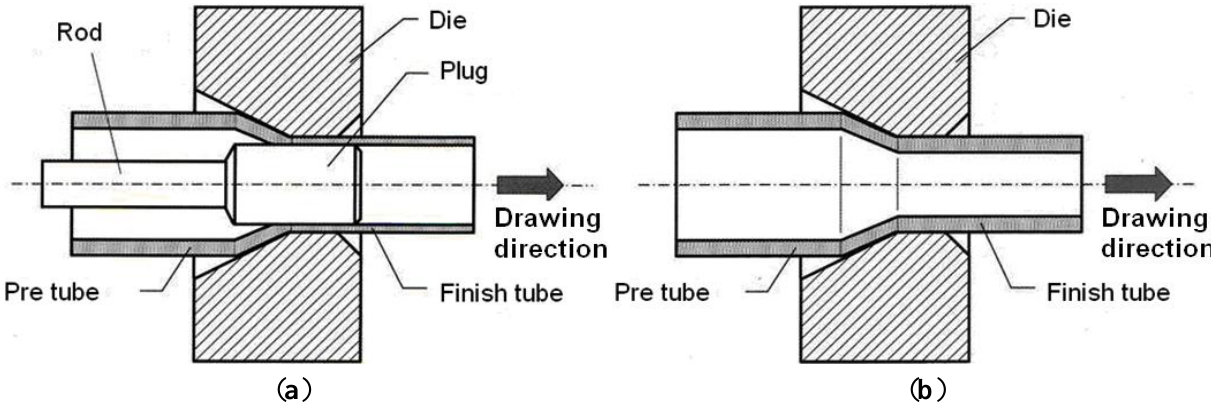
Figure 1. Drawing process with ( a ) a fixed plug; and ( b ) plug-less